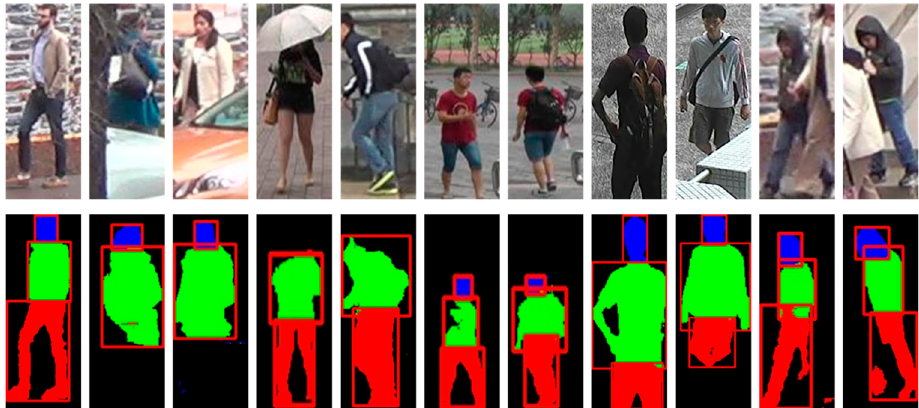
Figure 5. Examples of part semantic segmentation maps and corresponding bounding boxes of parts. The top row images are RGB images of person, and the bottom images illustrate their part segmentation by super-pixels and bounding boxes of human parts are demonstrated with red rectangles.